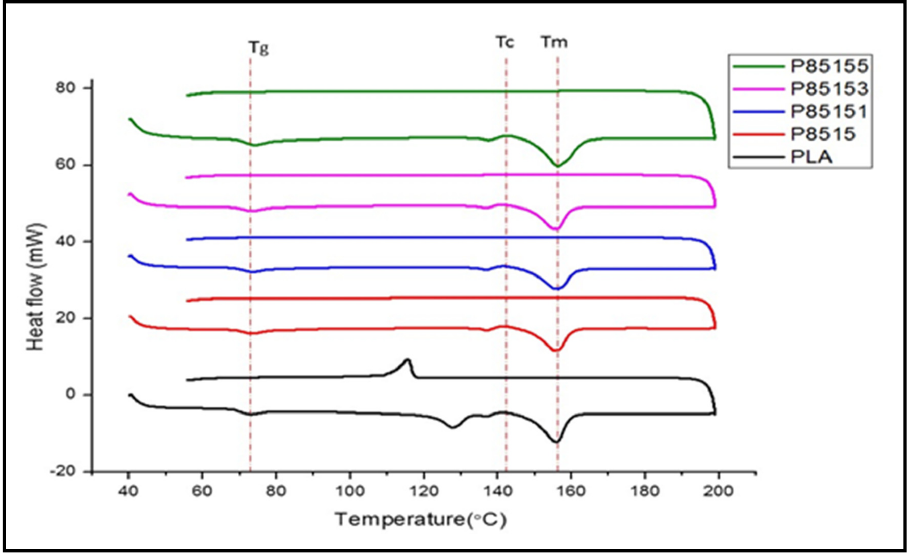
Figure 5. Differential scanning calorimetry for neat PLA, P8515, P85151, P85153, and P85155 biocomposites. Table 2. T on and T peak of neat PLA, PLA/chitosan, and PLA/chitosan/CNF biocomposite. Scheme.